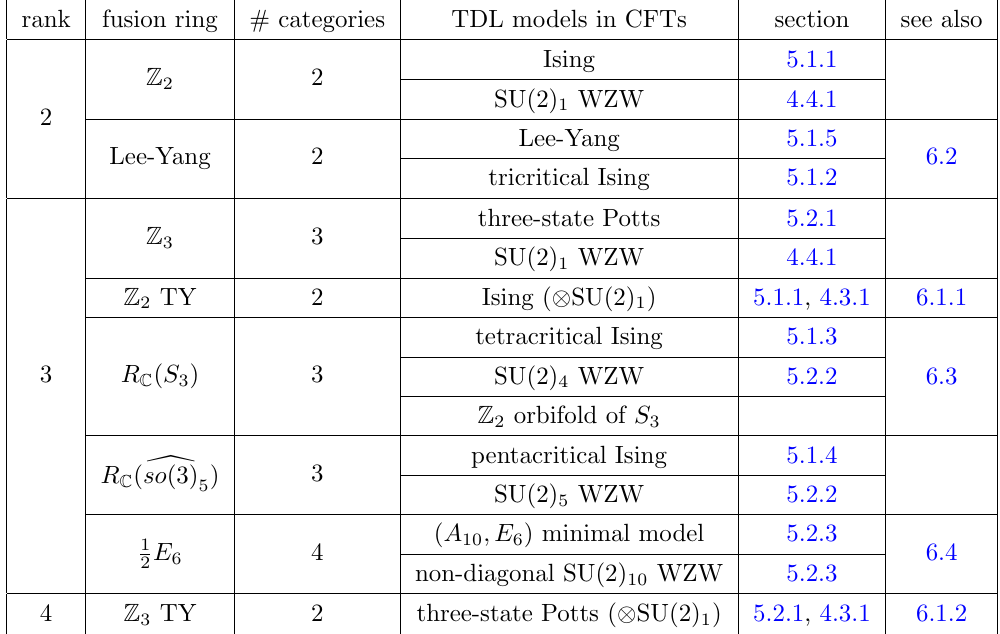
Table 2 . Fusion rings of small ranks, the corresponding number of fusion categories (solutions to the pentagon identity), and some examples of CFTs in which the fusion categories are realized by (a subset of) the TDLs. TY stands for Tambara-Yamagami. Note that not all the categories counted in the third column are realized in the models given in the fourth